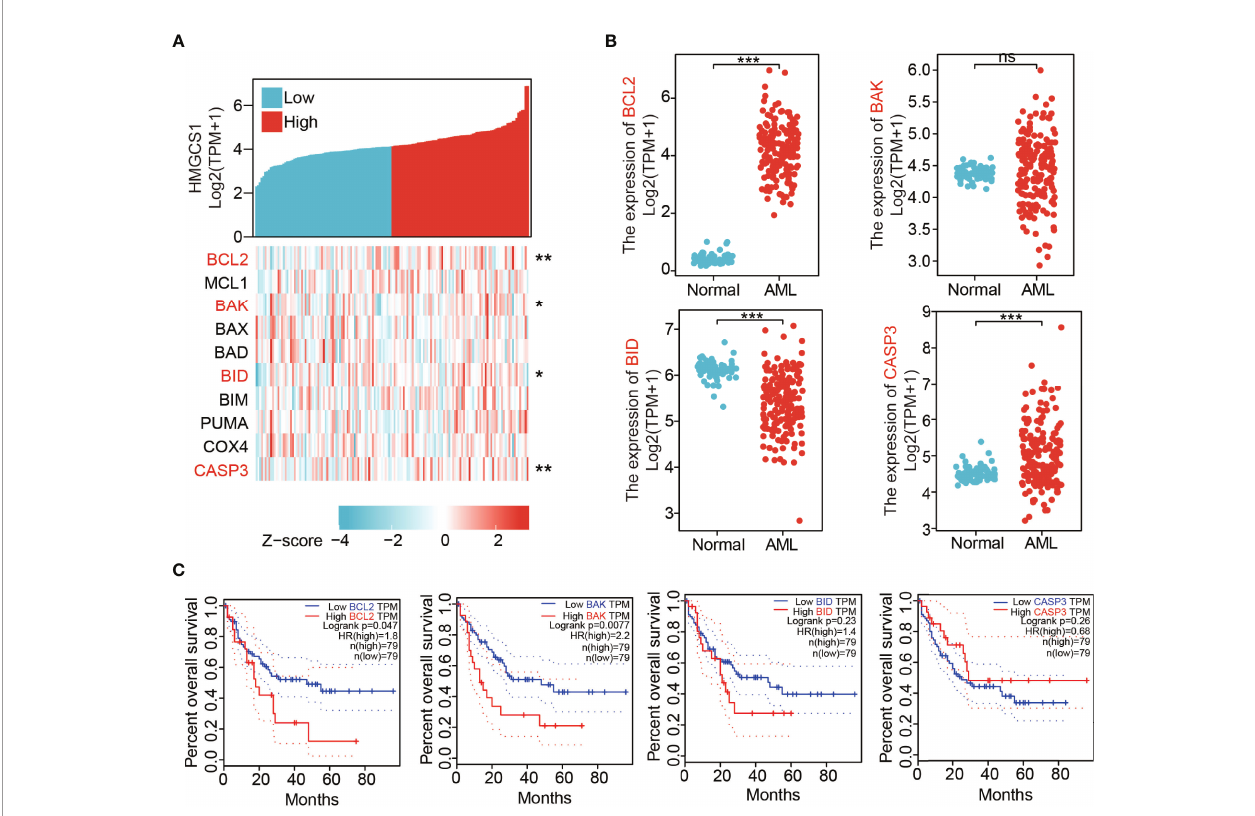
FIGURE 1 | Expression levels of 3-hydroxy-3-methylglutaryl-CoA synthase 1 (HMGCS1) correlated with those of apoptosis-related genes. (A) The correlation between HMGCS1 level and key apoptosis related genes by analyzing dataset in Xiantao. The genes included BCL2, MCL1, BAK, BAX, BAD, BID, BIM, PUMA, COX4, and CASP3. (B) The expression level of BCL2, BAK, BID, and CASP3 between patients with AML and normal controls utilizing the GTEx and TCGA databases. (C) The association of BCL2, BAK, BID, and CASP3 level with overall survival. *P<0.05, **P<0.01, ***P<0.001. ns, not signi fi